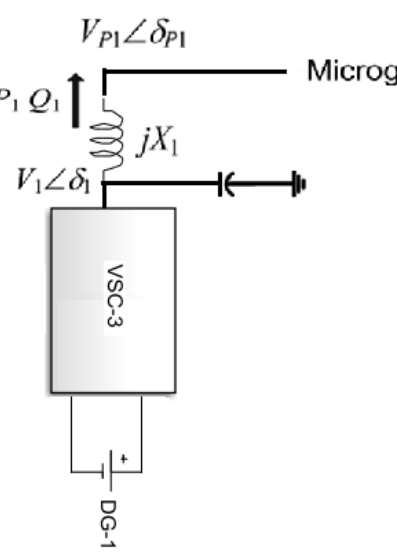
Figure 3. Power distribution from DG to microgrid.